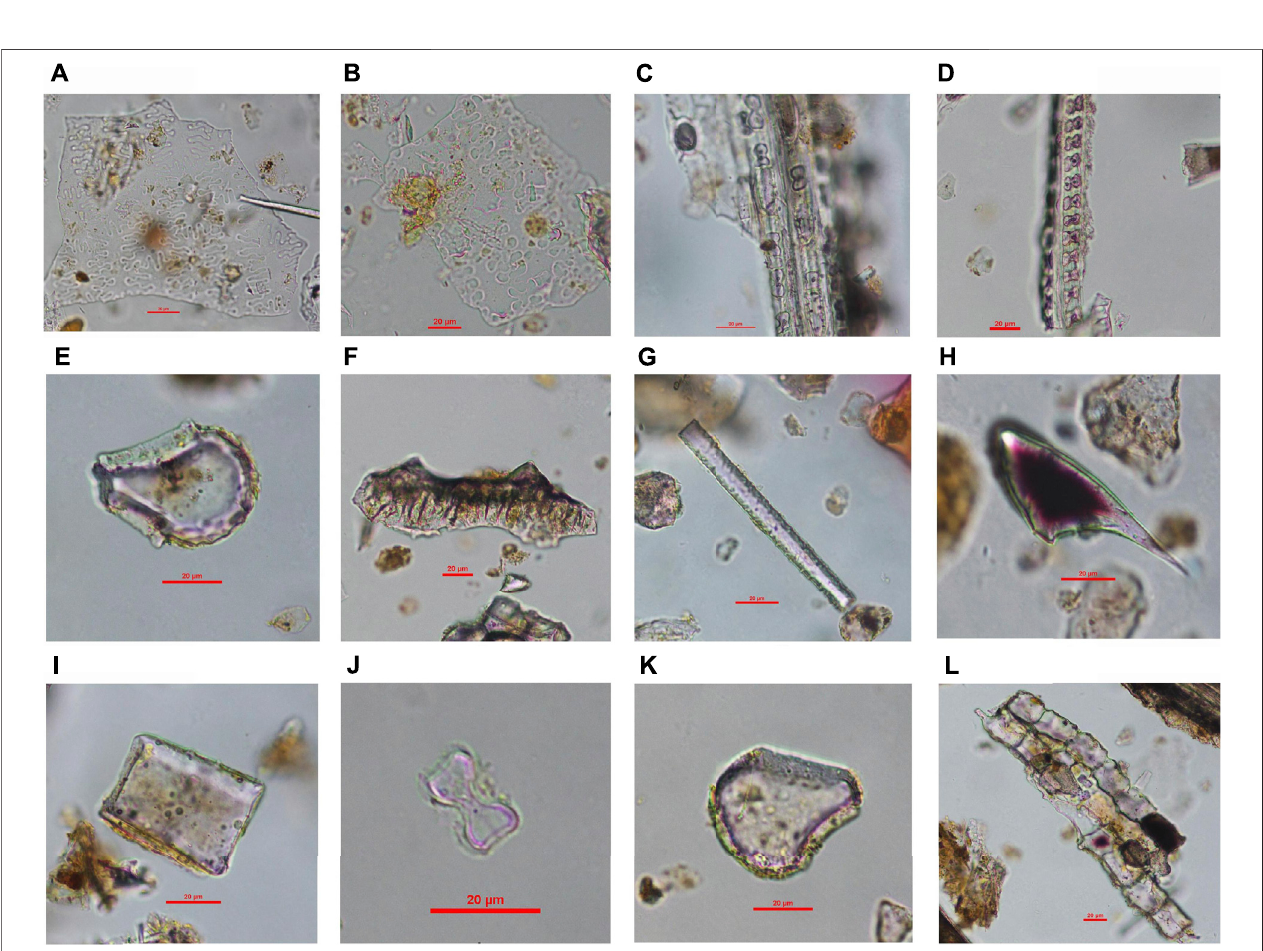
FIGURE 4 | Main phytolith types from the Suyang site. (A) η -type from husks of common millet, (B) Ω -type from husks of foxtail millet, (C) Vertically-bilobe from Poaceae, (D) parallel-bilobe from rice leaf/stem, (E) bulliform from rice leaf, (F) double-peaked from rice husk, (G) smooth elongate, (H) pointed, (I) square, (J) bilobate, (K) bulliform, (L)